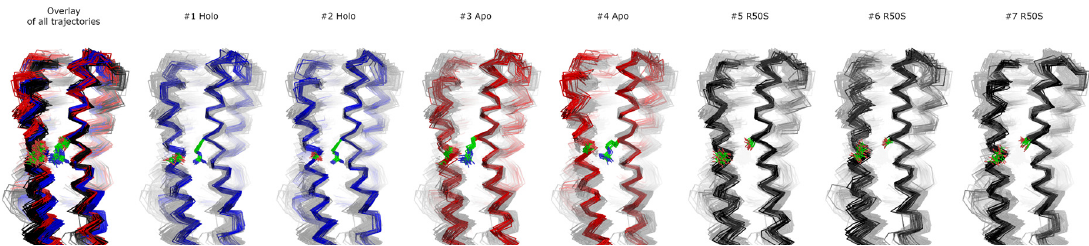
Figure 8. Structural snapshots from the last 200 ns of the simulations. 20 snapshots taken each 10 ns are shown. In each case, only one protomer is shown. Residues Arg50 or Ser50 and Asp133 are visualized as green sticks with oxygen and nitrogen atoms in red and blue, respectively. All other residues are visualized as ribbons. The structures were aligned using the residues 45 to 55 from both protomers. Individual MD trajectories may be found in the Supplementary Information.